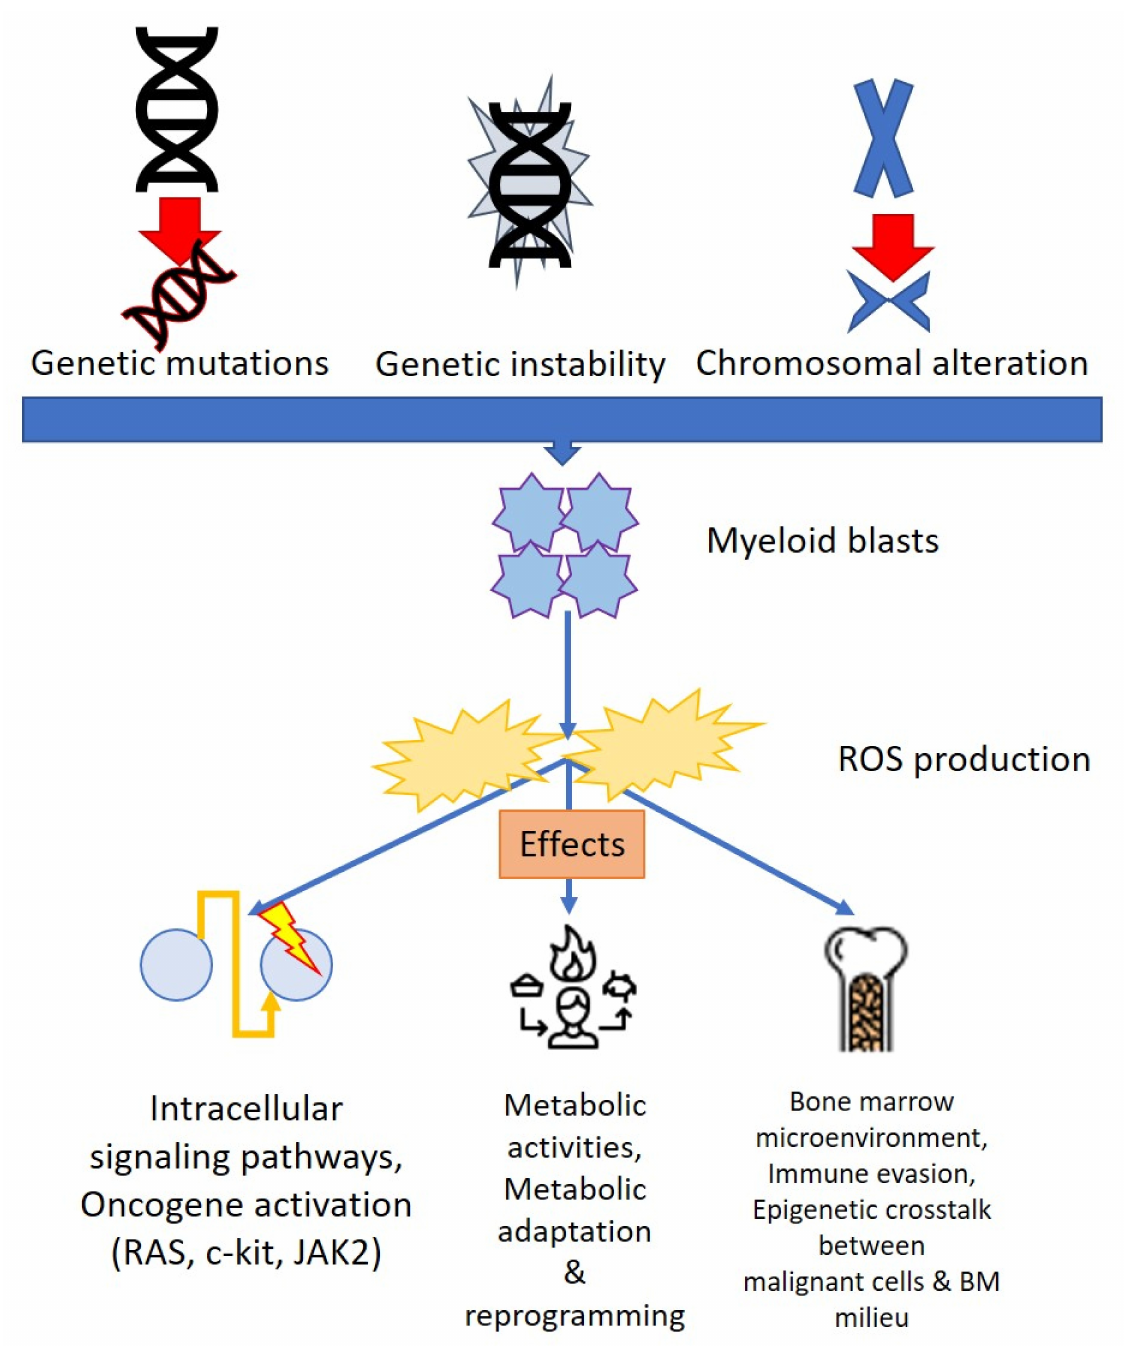
Figure 2. Effects of ROS on leukemogenesis. Chromosomal, genetic, and epigenetic alterations of the leukemic cells co-occur to determine the abnormal production of ROS capable of inducing alteration of the intracellular signaling pathways, modification of the intracellular metabolic activities (energy balance and chemoresistance), and an effect on the cells of the medullary microenvironment (angiogenesis, bone homeostasis, extracellular matrix remodeling, immune activity). Of particular interest is the result that the generation of ROS by leukemic cells appears quite different according to their type; this can play a role in the prognostic